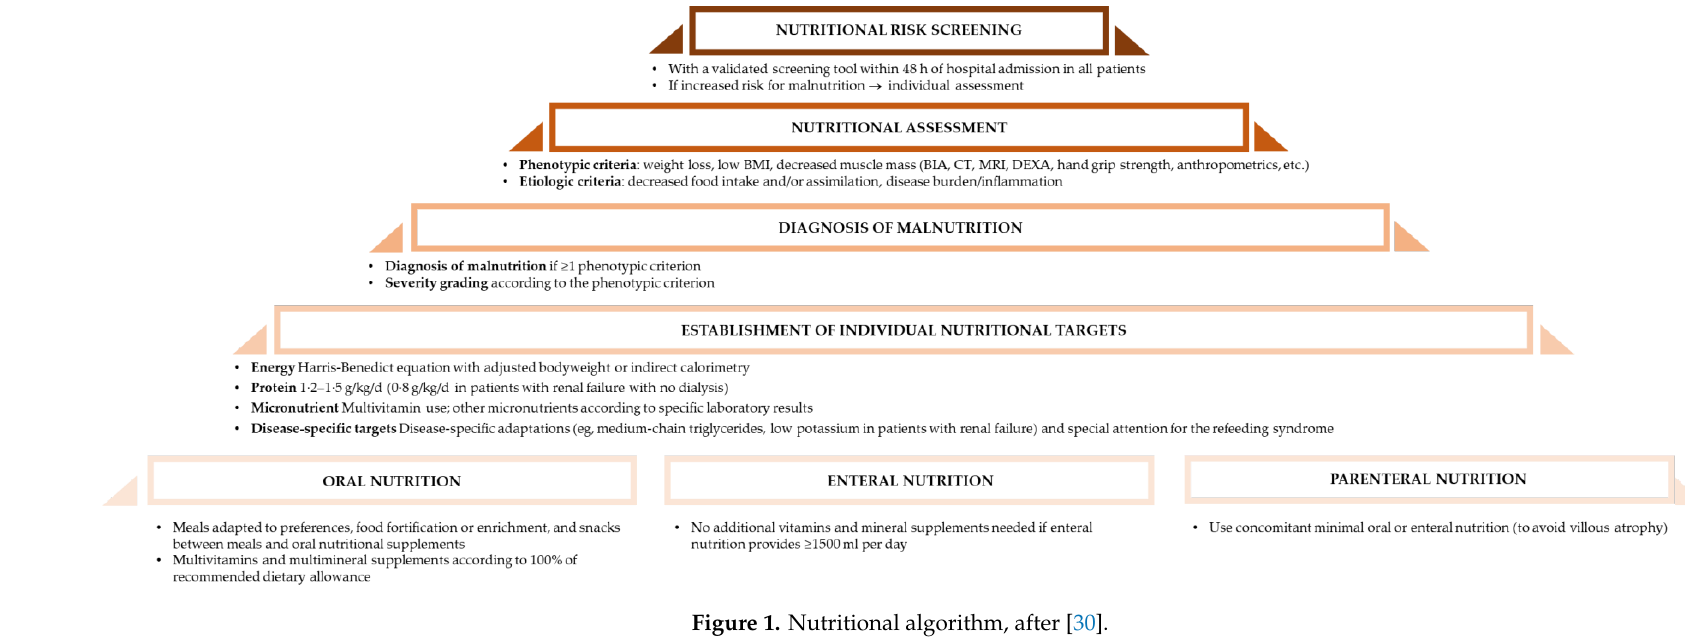
Figure 1. Nutritional algorithm, after [30].